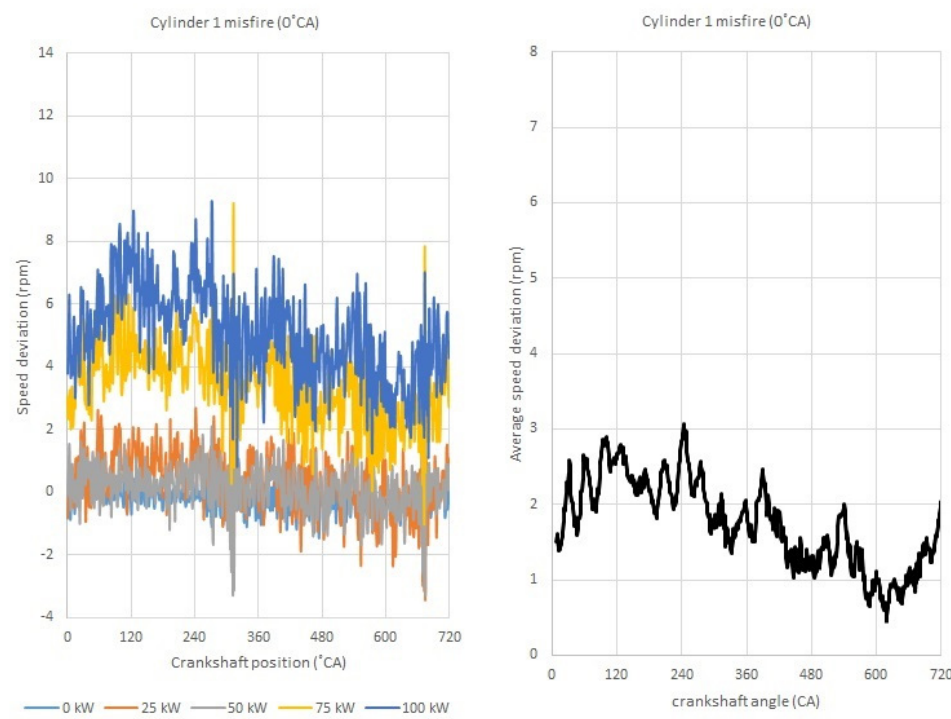
Figure 21. Instantaneous speed differences and the average deviation of the combustion process in cylinder 1 of a Sulzer 5 BAH 22 engine.